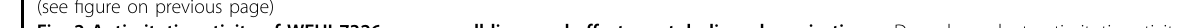
Fig. 2 Antimitotic activity of WEHI-7326: cancer cell lines and effects on tubulin polymerization. a Dose-dependent antimitotic activity of WEHI-7326, nocodazol and taxol in tumor cell lines SW480 (colorectal) and MDA-MB-231 (breast). Data are presented as percentage of cells in G2/M after overnight incubation with increasing concentrations of inhibitors and PI staining followed by fl ow cytometry analysis. Mean average of 3 independent experiments ±SEM. b EC 50 values (nM) for G2/M arrest on SW480 and MDA-MB-231 cell lines, given as mean average of 3 independent experiments ±SEM. c Western blot analysis of mitotic arrest in SW480 and MDA-MB-231 cells treated with EC 50 concentrations of WEHI-7326 or Paclitaxel as marked by expression of phosho-S10 Histone H3 (p-HH3 S10), at different timepoints post treatment. Expression of β -actin provided as loading control. d Cell cycle analysis of LIM1899 cells 72 h post treatment with increasing concentrations of WEHI-7326 as measured by PI staining for DNA content followed by fl ow cytometry analysis. Sub-G1 represents apoptotic fractions and >4 N cell fractions of mitotic slippage. e Immuno fl uorescence confocal microscopy of tubulin polymerization in SW480 cells treated by various agents. Cells were incubated for 24 h with control (0.1% DMSO), nocodazole (1 μ M), paclitaxel (1 μ M), myoseverin B (1 μ M) or WEHI-7326 (1 μ M). Cells were fi xed and stained with β -tubulin antibody (green) and DAPI (DNA; blue) and phalloidin (actin, red). Shown are single confocal sections and enlarged areas (3x) to highlight changes in microtubule network; scale bar = 20 μ m. Representative images from 2 independent experiments. f Cellular tubulin polymerization assay in cells: SW480 cells were incubated overnight with paclitaxel, myoseverin B or WEHI-7326, then processed to detect fractions of polymerized (P) and soluble (S) tubulin by western blot analysis. Representative blot of 3 independent experiments. g Tubulin polymerization was assessed in vitro over time using a fl uorescence-based tubulin polymerization assay (BK011P). Tubulin was incubated with control (DMSO), paclitaxel (3 μ M), nocodazole (15 μ M) and WEHI-7326 at indicated concentrations (in DMSO). Polymerization was measured by excitation at 360 nm and emission at 420 nm. Representative graph of 3 independent experiments performed in duplicates.